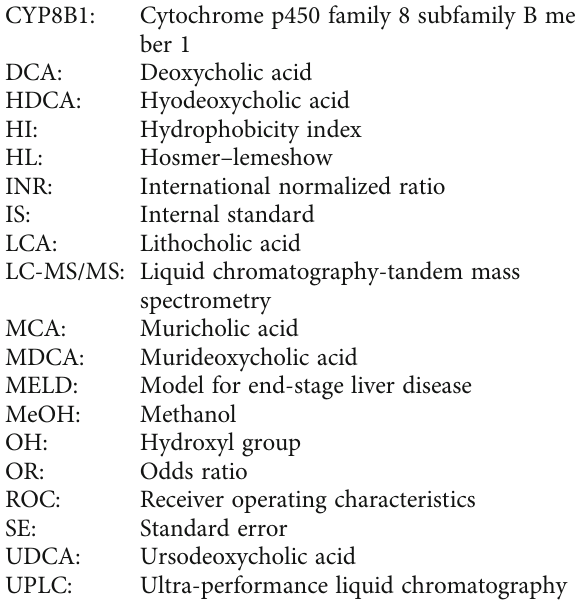
Supplementary Figure S1: histograms for the BALDC, non- BA, mixed BA and non-BA, and original MELD model ’ s